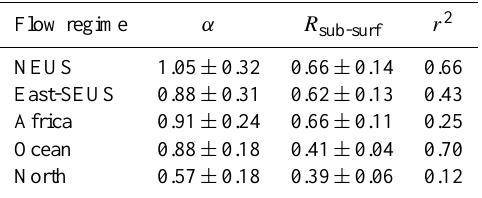
Table 3. Average Ångström exponent, α , and R sub-surf , along with the correlation between these factors broken down by flow regime, with standard deviation ( σ) .